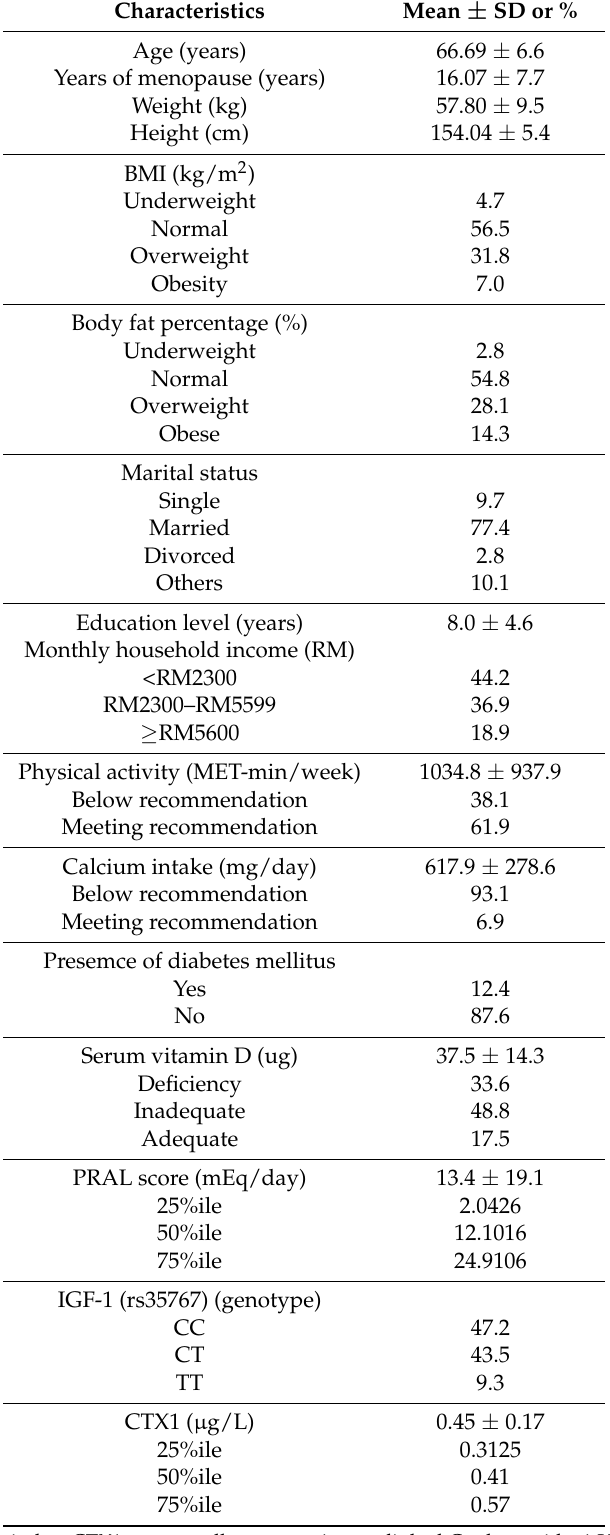
Table 1. Characteristics of women ( n =